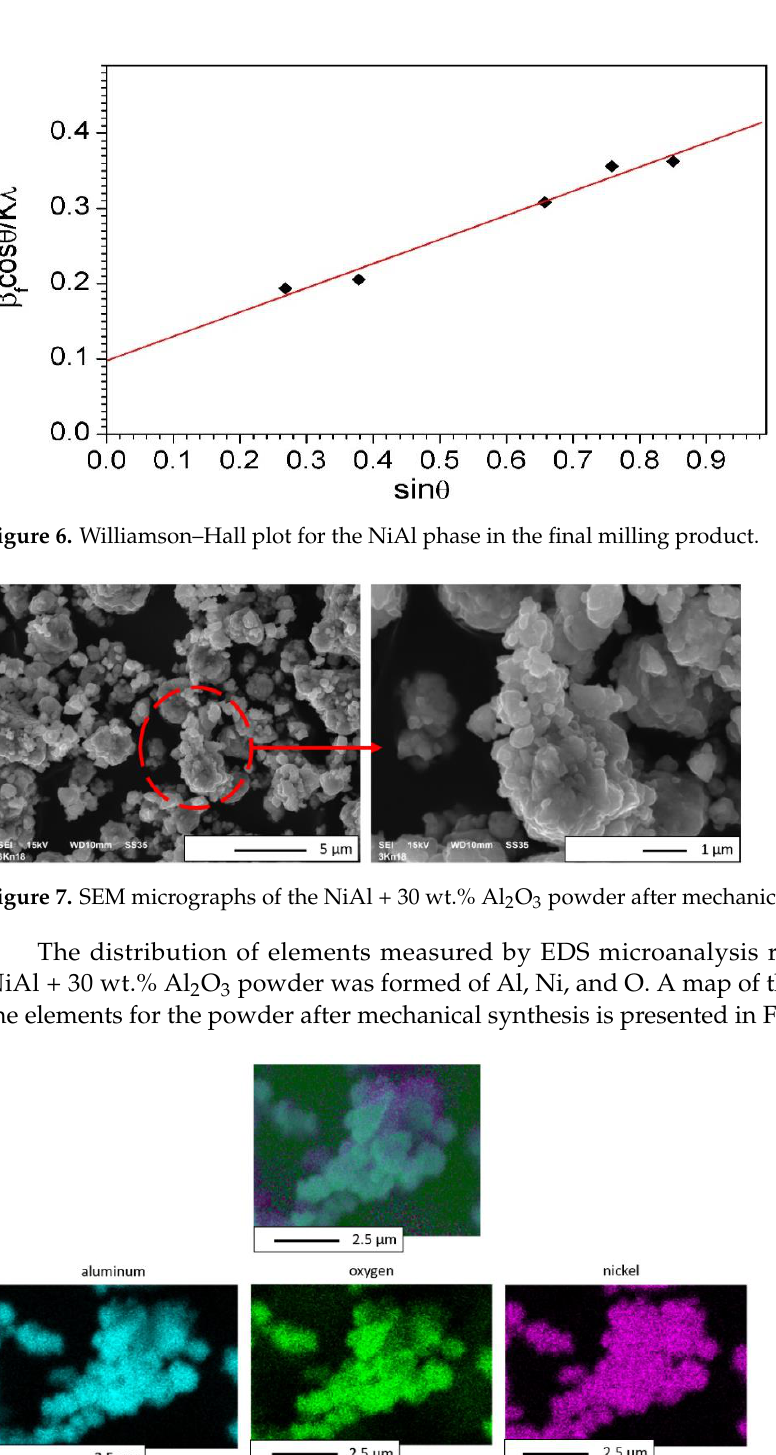
Figure 6. Williamson–Hall plot for the NiAl phase in the final milling product.